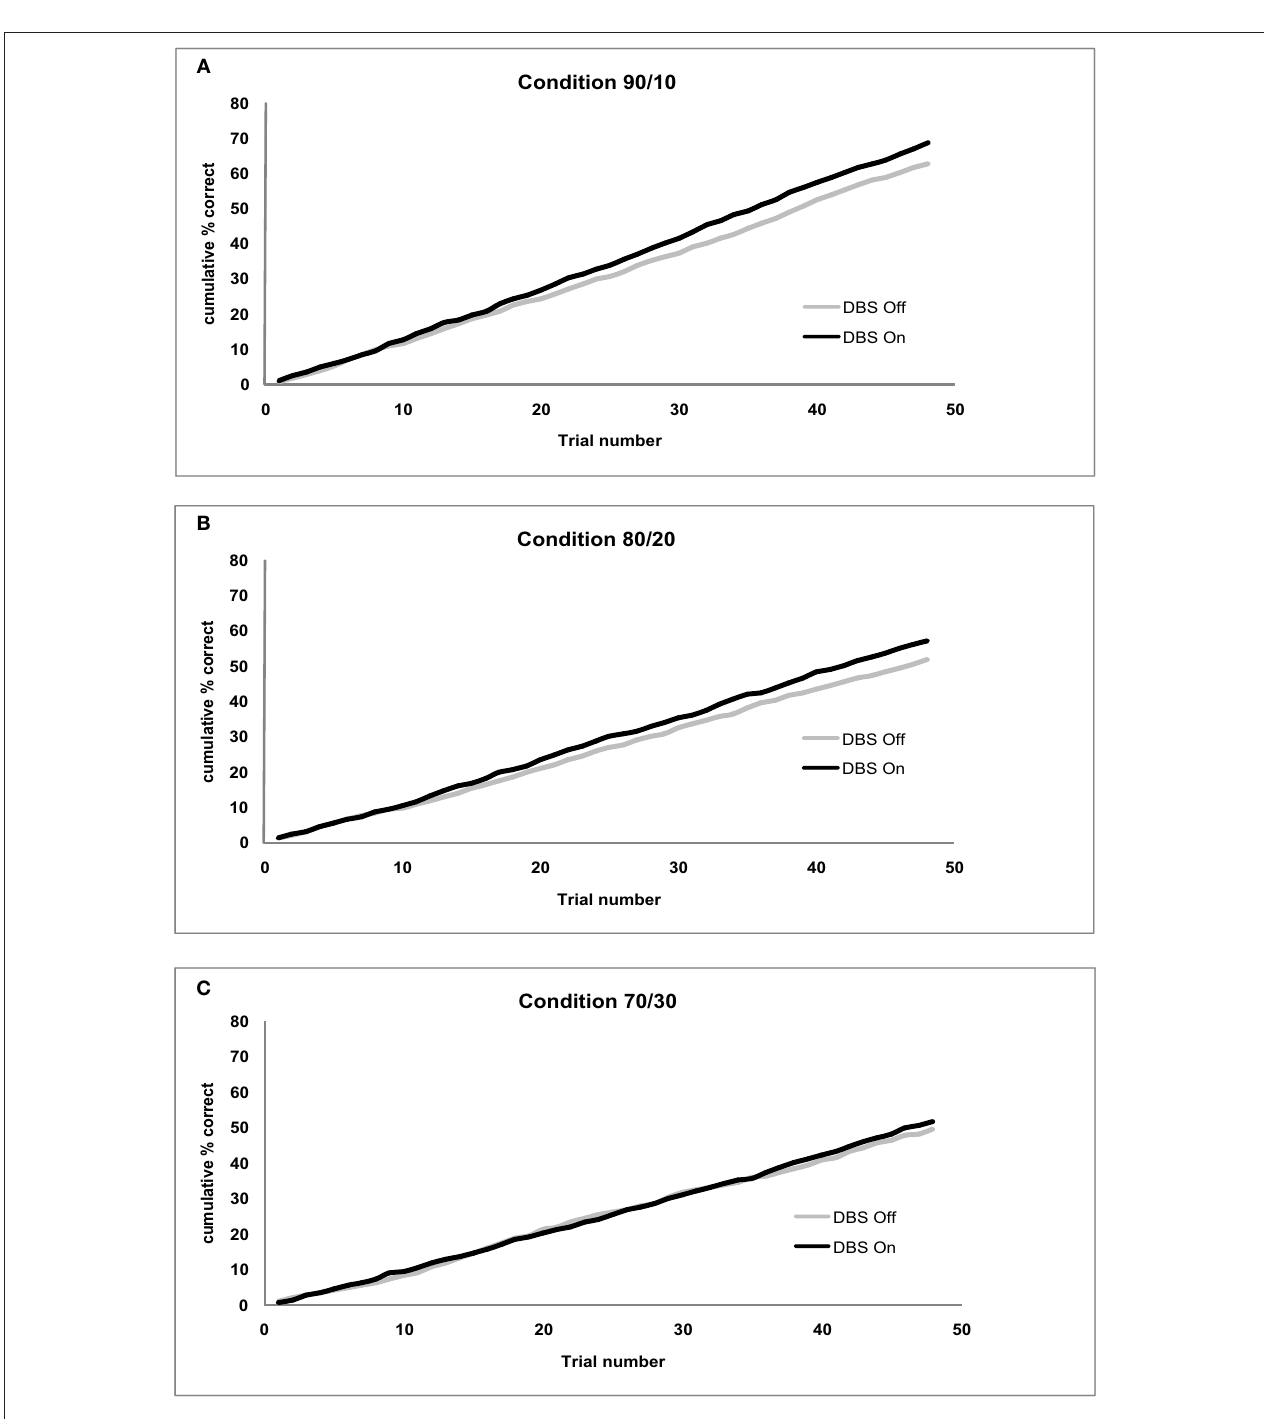
Figure 2 | (A) Cumulative accuracy for the 90/10 Condition by Stimulation (On/Off). (B) Cumulative accuracy for the 80/20 Condition by Stimulation (On/Off). (C) Cumulative accuracy for the 70/30 Condition by Stimulation